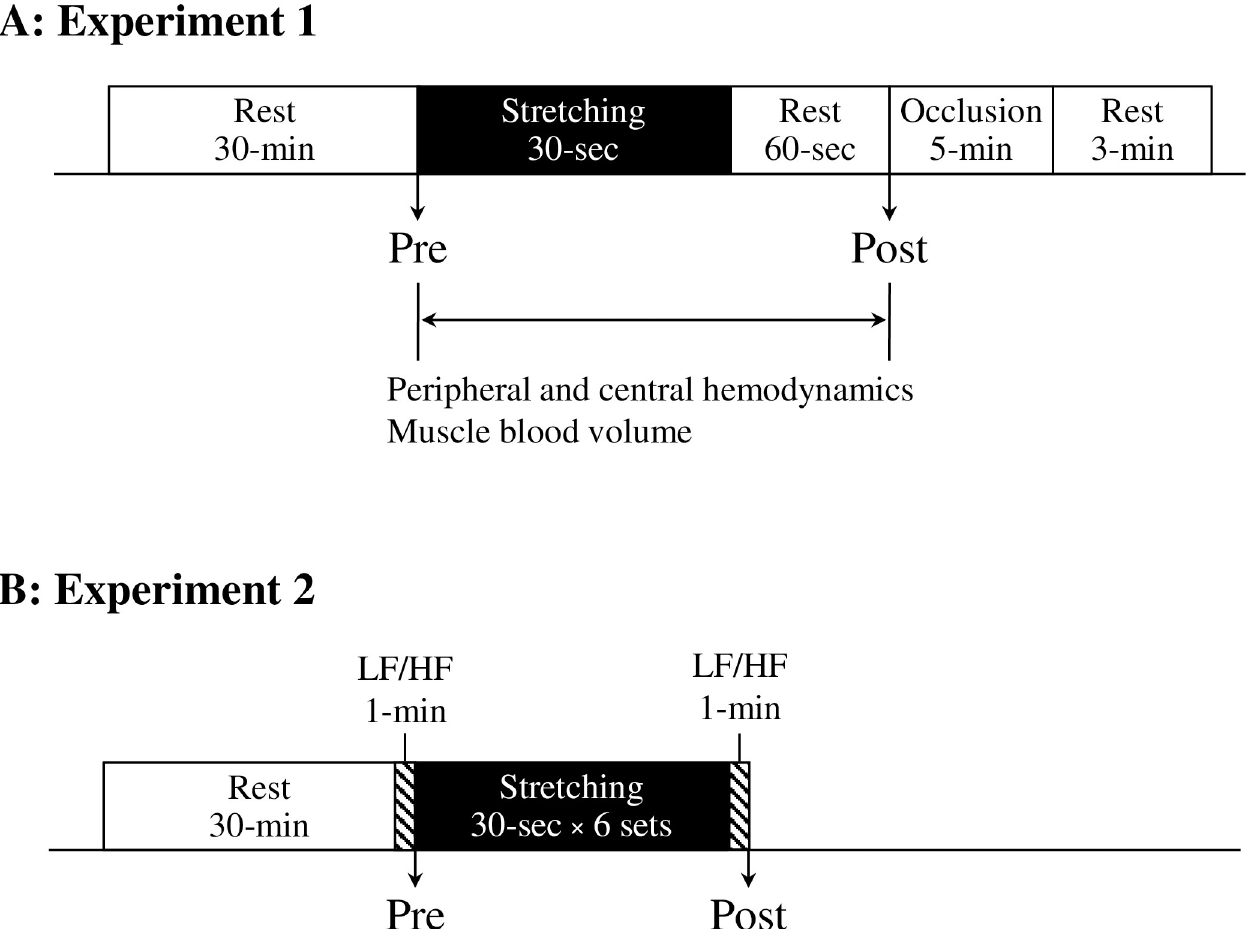
Fig 1. Design of experiments 1 (A) and 2 (B). In Experiment 1, blood pressure is measured before stretching (Pre) and after stretching (Post). Peripheral (artery diameter, mean blood velocity, blood flow, shear rate) and central (heart rate, stroke volume, cardiac output) hemodynamics and muscle blood volume (total hemoglobin) are measured during the stretching session. In Experiment 2, brachial-ankle pulse wave velocity (baPWV), femoral-ankle PWV (faPWV), heart rate, blood pressures are measured at Pre and Post. low frequency (LF)/high frequency (HF) is measured for 1-min immediately before and after